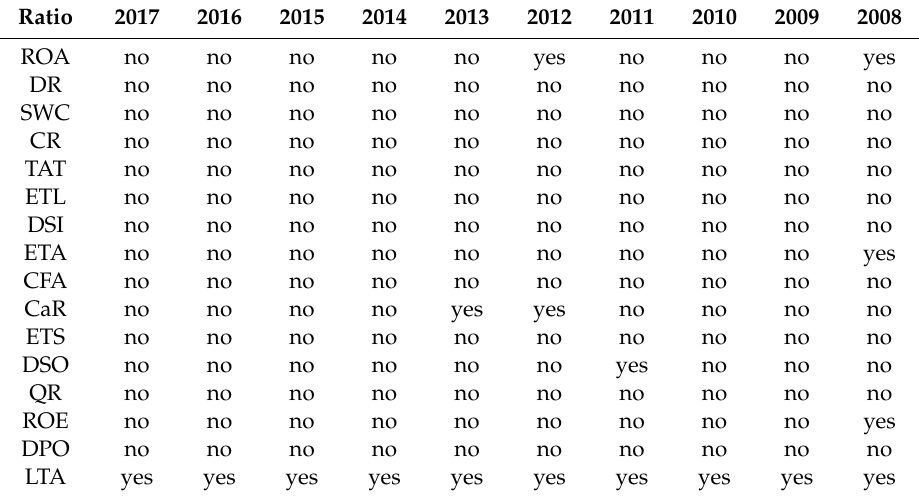
Table 4. Summary of results of Student’s t-test, 2008–2017.